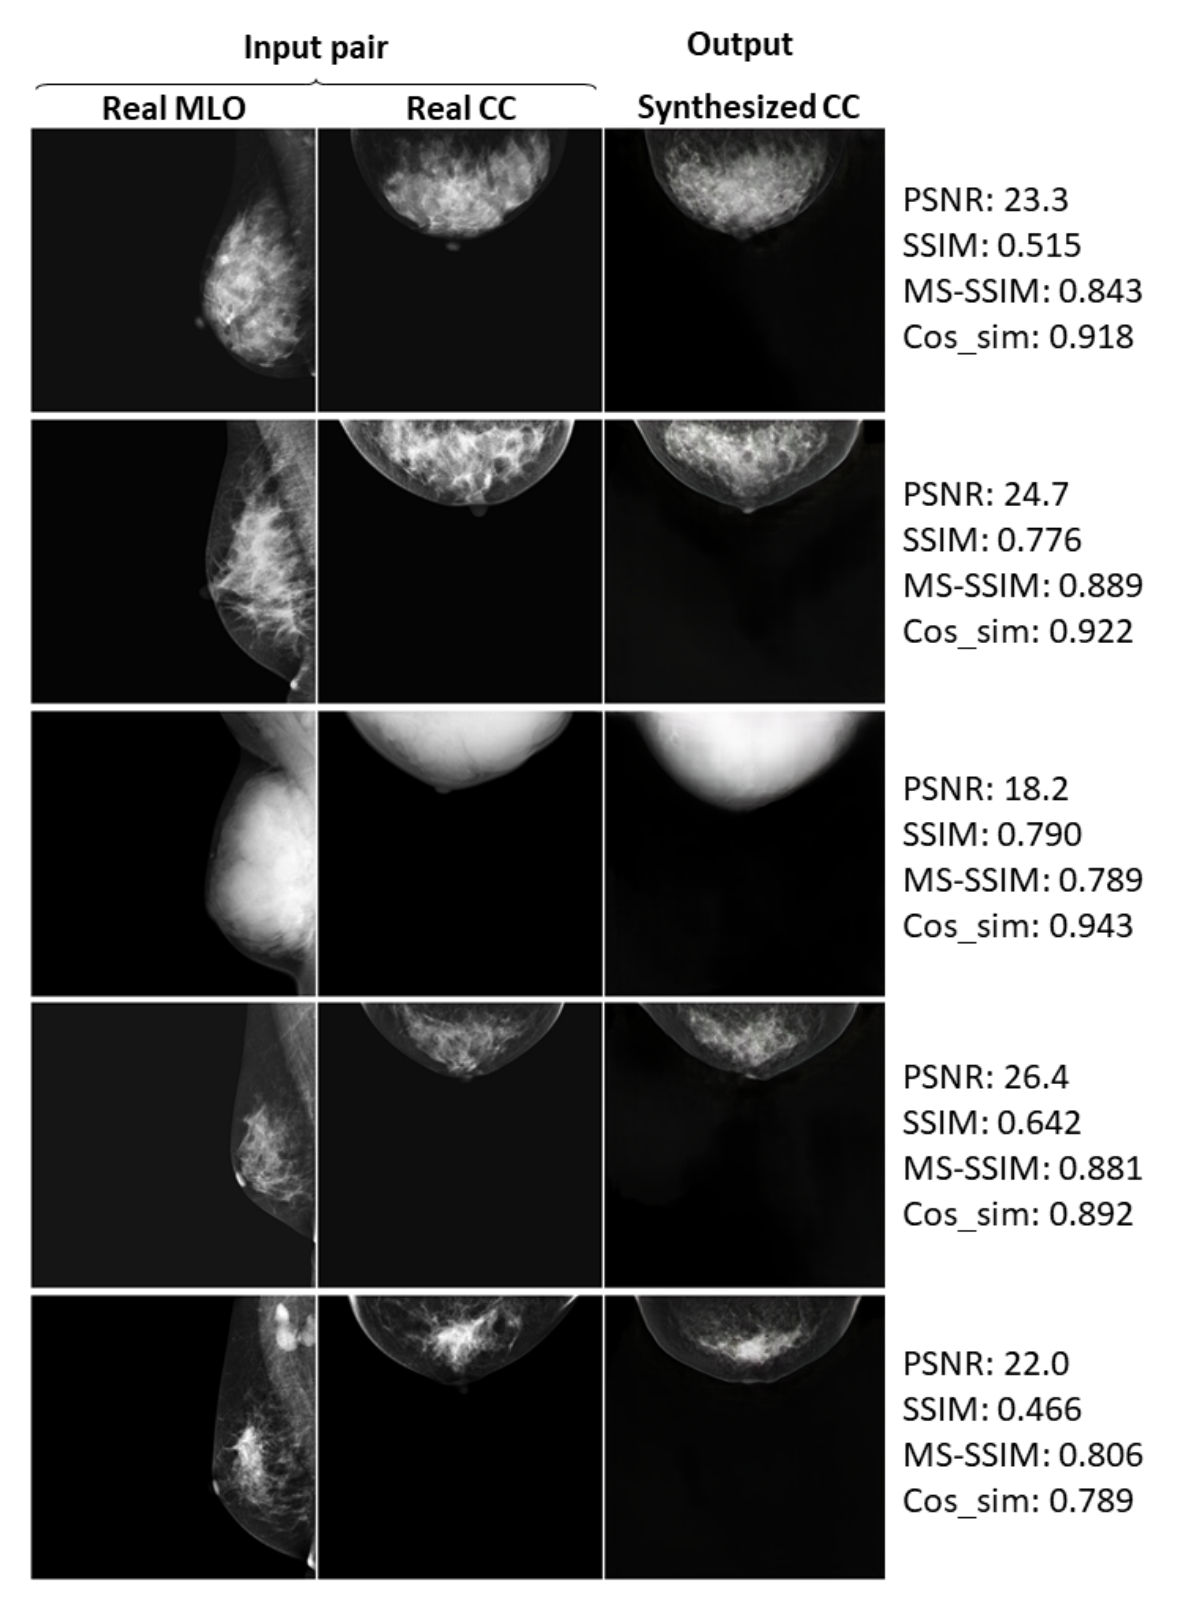
Figure A2. Real and synthesized CC-view mammograms at 256 × 256 resolution: further